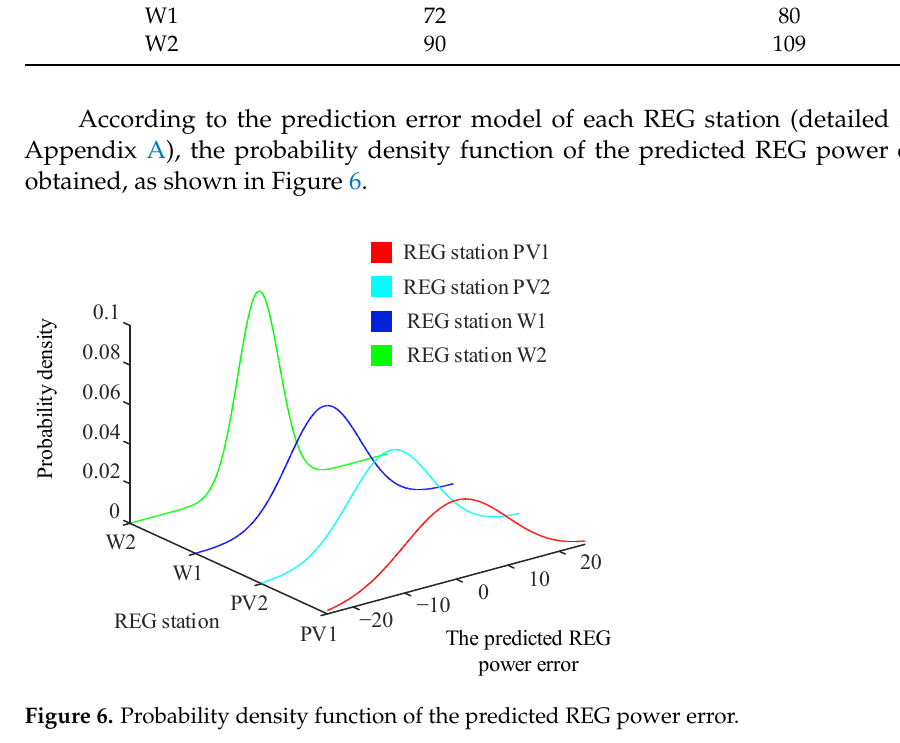
REG station PV1 REG station PV2 REG station W1 REG station W2 Figure 7. Probability that each REG station can achieve the expected output. At this point, the section margin SM t P is 21 MW. According to the section margin allocation function, the objective is to maximize the probability that all REG stations in the REG cluster can meet the output command after the margin allocation.